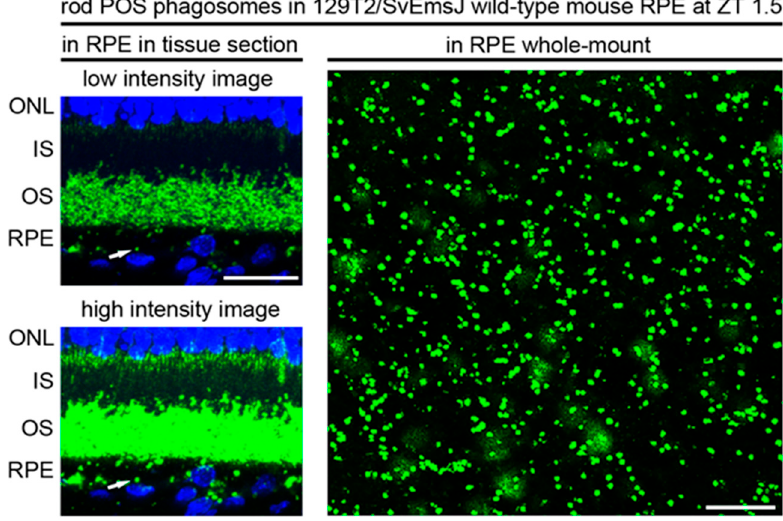
Figure 1. Whole-mount RPE phagosome assessment samples a higher number of RPE per sample than assessment in sagittal sections. Images show 129T2/SvEmsJ tissue obtained at ZT 1.5. Note that detection of RPE phagosomes in tissue sections (left panels) requires high-intensity imaging (lower left), resulting in overexposed intact outer segments (OS). A representative rod POS phagosome is indicated by the arrow. Quantification of high-intensity sections as shown yields a rod POS phagosomes content of 15.3 ± 1 phagosomes per 100 µm length of the central retina on average (mean ± S.D., n = 5 eyes from 5 different mice). Imaging the same rhodopsin staining in RPE whole- mount samples (image on the right as indicated) is not confounded by the presence of intact outer segments. Moreover, whole-mount observation allows quantification of the full phagosome load per cell in multiple cells per sample and, thus, importantly, robust assessment of cell-to-cell variability. Quantification of whole-mount images as shown yields 255 ± 29 phagosomes per (100 µm) 2 area of RPE on average (mean ± S.D., n = 5). For either quantification method, rhodopsin- positive particles were counted as phagosomes if their diameter was at least 0.5 µm. Scale bars in both fields are 20 µm. Tissue section data are reproduced from Esposito et al., Invest. Ophthalmol. Vis. Sci ., 2021 , 62 :7 [40]. RPE whole-mount data are reproduced from Mazzoni et al., Redox Biol . 2021 , 42 , 101918 [37].